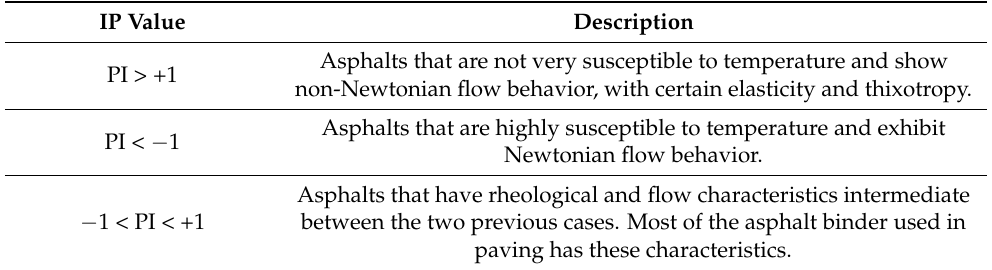
Table 2. PI classification of asphalt binders [32].